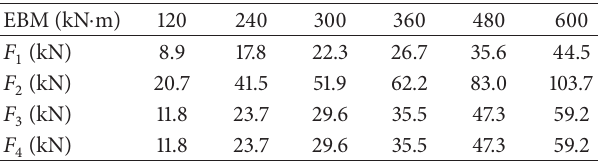
Table 5: Step loading in the